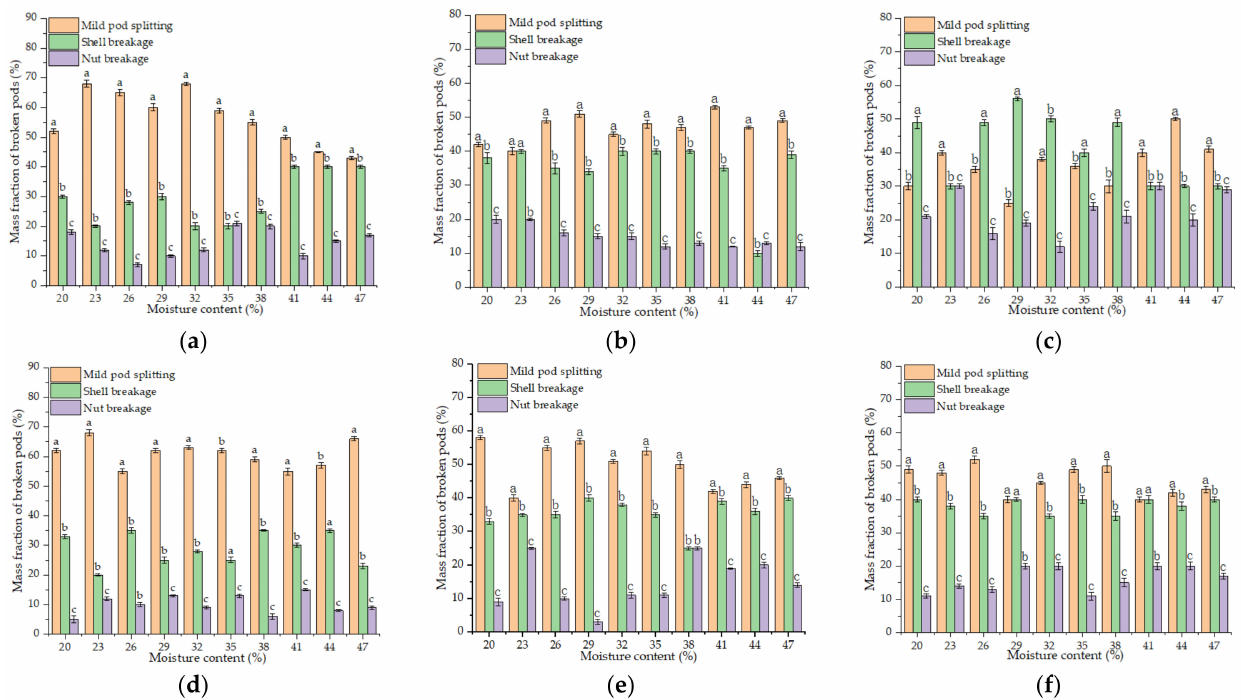
Figure 12. Distribution of crushed pods under different experimental treatments: ( a ) 2021 T1 Shan- hua 9; ( b ) 2021 T2 Shanhua 9; ( c ) 2021 T3 Shanhua 9; ( d ) 2021 T1 Huayu22; ( e ) 2021 T2 Huayu22; ( f ) 2021 T3 Huayu22,different lowercase letters in the pictures indicate significant